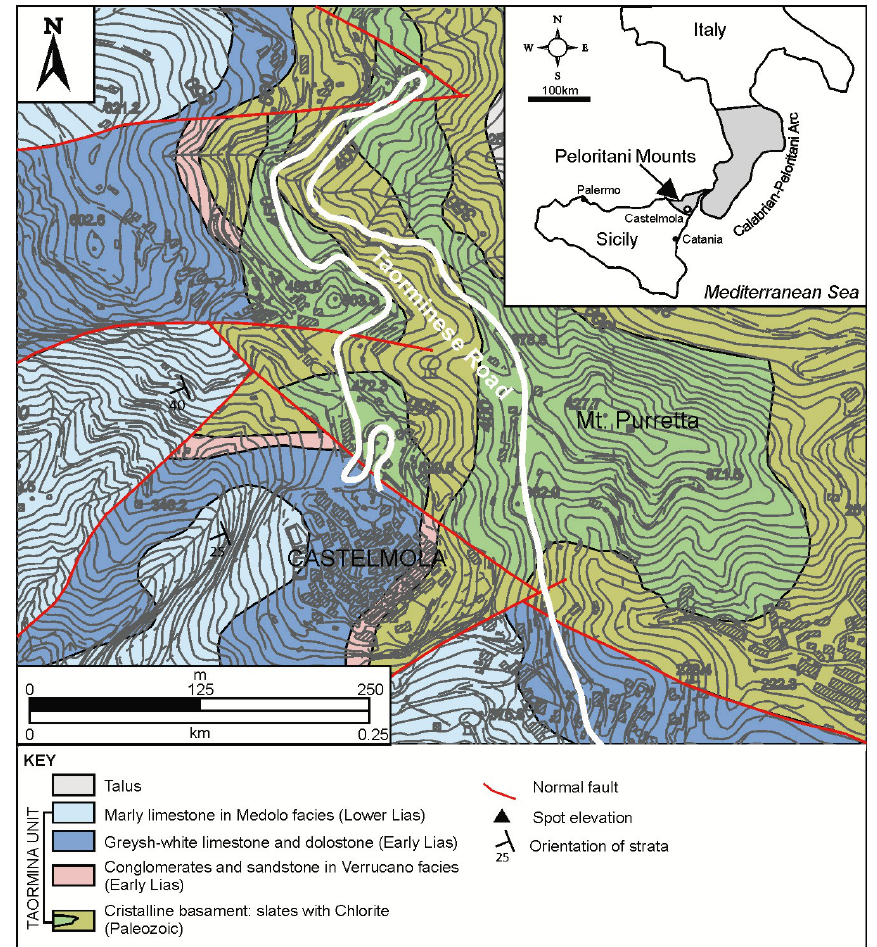
Figure 2. Geological setting of the study area. White line indicates the surveyed TR segment (modified after Carbone et al., 1994).